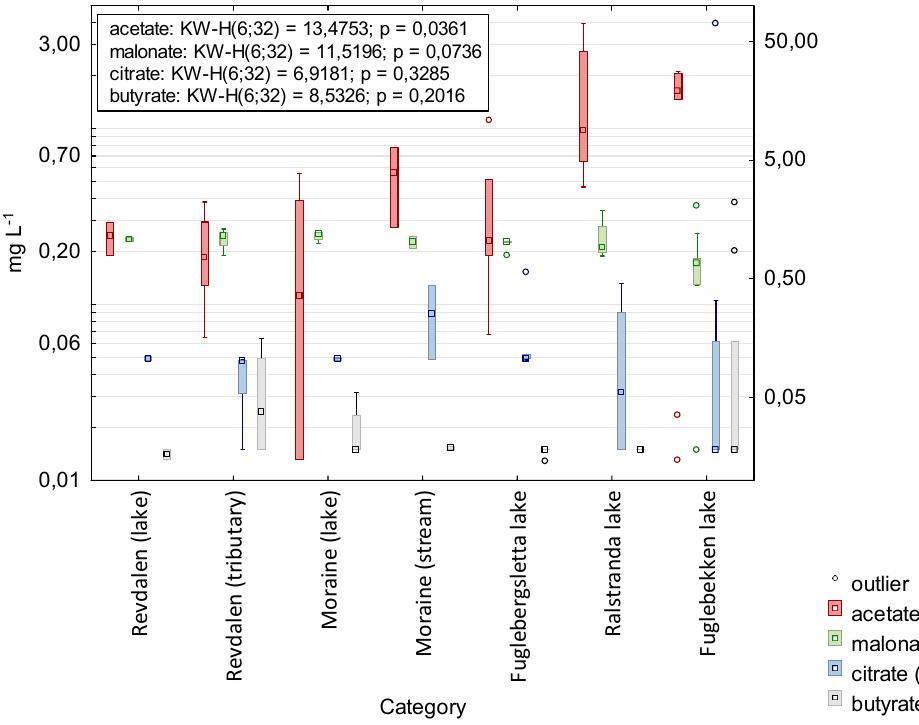
Figure 6. Selected short-chain fatty acids (SCFAs) concentrations, which exceeded detection limits in at least n = 9 samples, from lakes and streams in the Hornsund area. (R) or (L) signifies which Y-axis (right or left) the particular parameter is plotted upon. Box = results between first (Q 1 ) and third quartile (Q 3 ); empty square = median (Q 2 ); whiskers = range of non-outlier results; outlier = a value further than 1.5 box span (Q 3 − Q 1 ) beyond Q 3 or Q 1 .